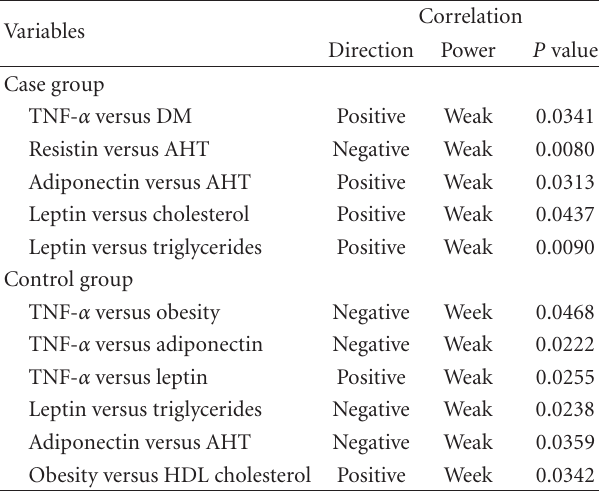
Table 4: The results of correlation